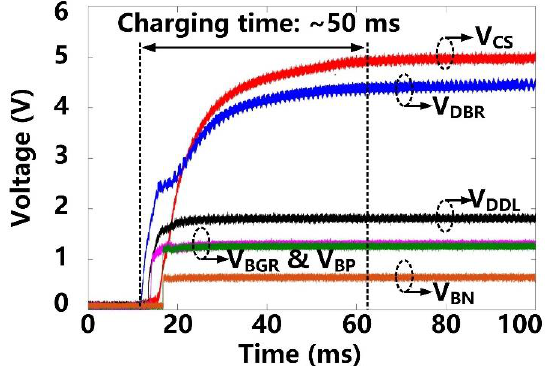
Figure 7. Transient waveforms of the power management block at starting up.